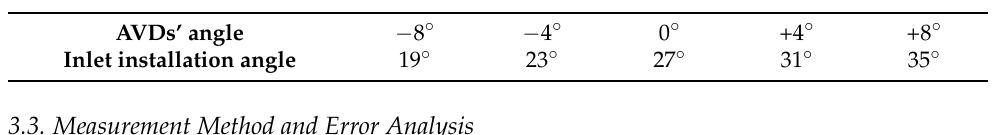
Table 3. Corresponding relationship between the AVDs’ angle and inlet installation angle of